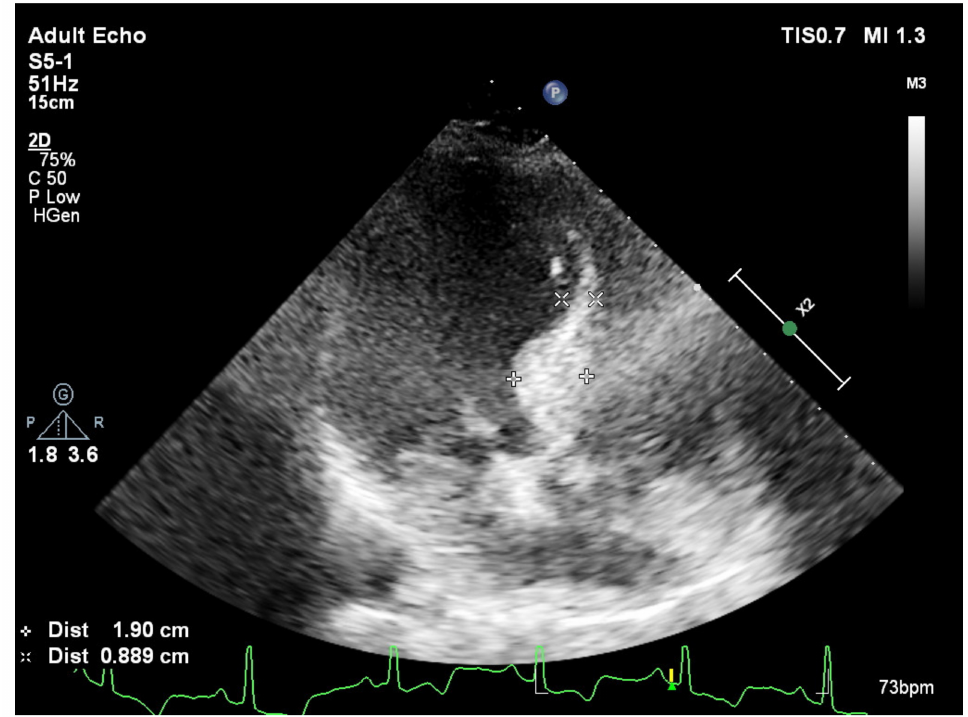
Figure 3. Predominantly placed hypertrophy over septal base from apical 4 chamber view during end-diastole in a patient with aortic stenosis and basal septal